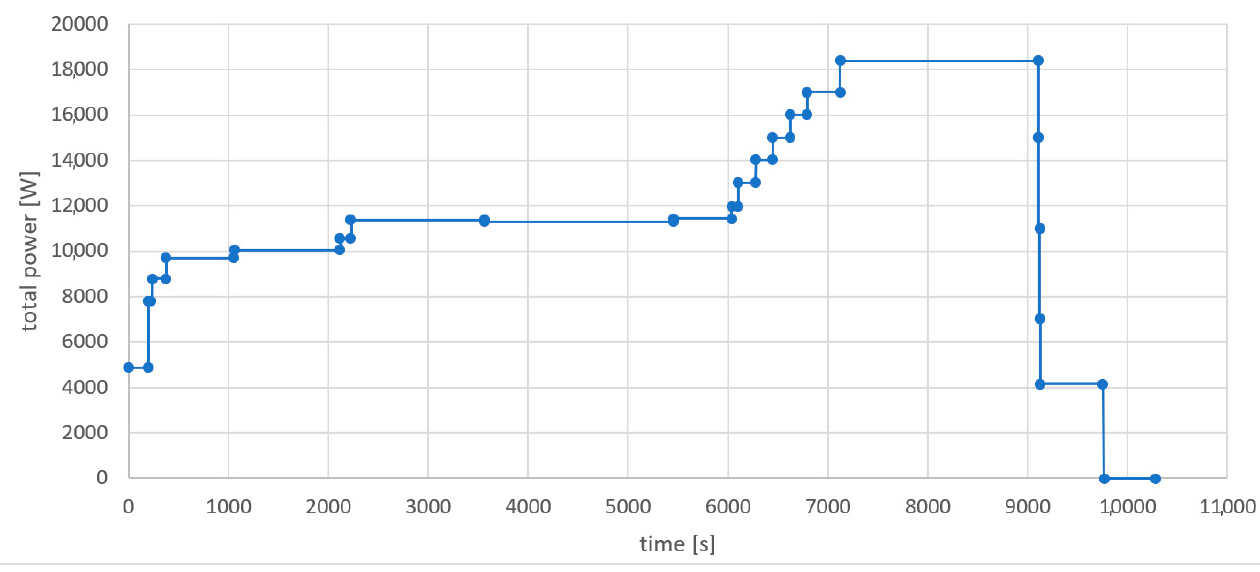
Figure 5. Test bundle electrical heating power [12].